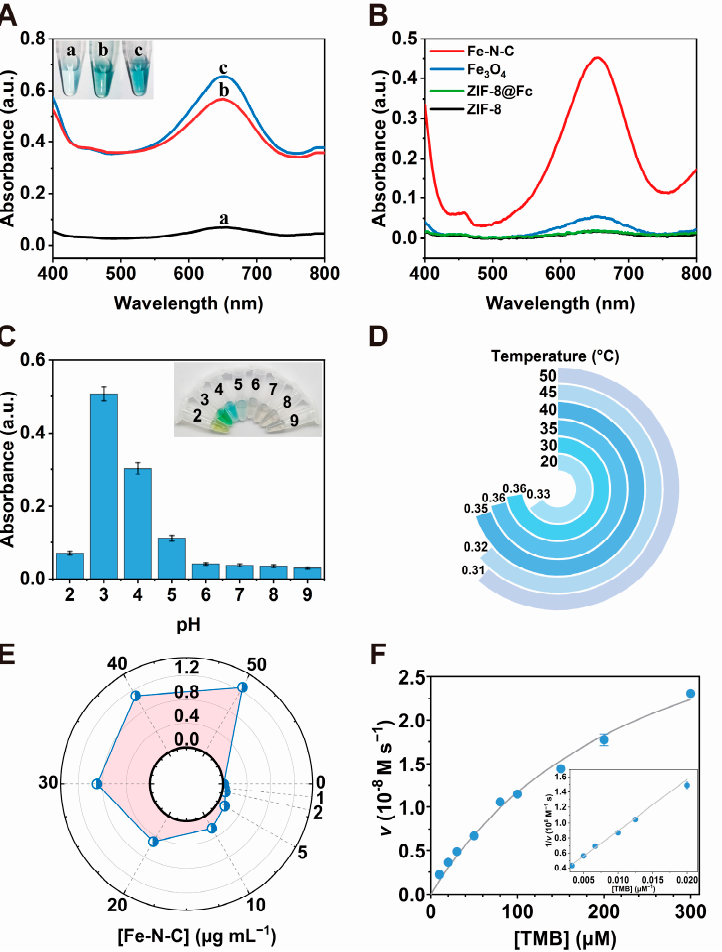
Figure 3. ( A ) UV–vis absorption spectra of (a) TMB + H 2 O 2 , (b) TMB + Fe-N-C, and (c) TMB + Fe-N-C + H 2 O 2 . Inset: corresponding photo of the color reaction. [TMB] = 0.1 mM; [H 2 O 2 ] = 1 mM; [Fe-N-C] = 20 mg mL − 1 . ( B ) Comparison of the oxidase-like activity of different nanomaterials. ( C – E ) Effect of pH ( C ), temperature ( D ), and catalyst concentration ( E ) on the oxidase-like activity of Fe-N-C. ( F ) Steady-state kinetic curve of Fe-N-C toward TMB. Inset: Lineweaver–Burk